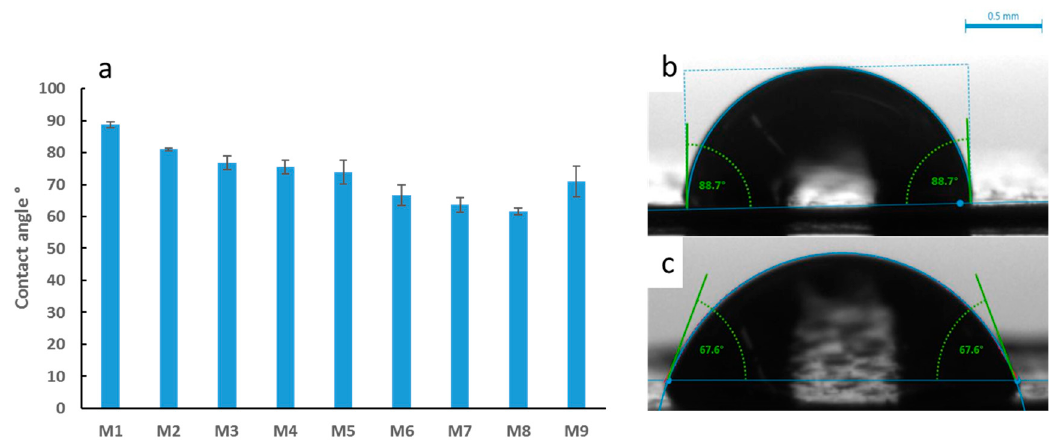
Figure 6. Average water contact angle readings for the synthesized PES membranes ( a ), sample photographs of water droplets with angle measurements for selected samples of M1 ( b ) and M8 ( c ). Each bar represents the mean ± SD of five independent readings.